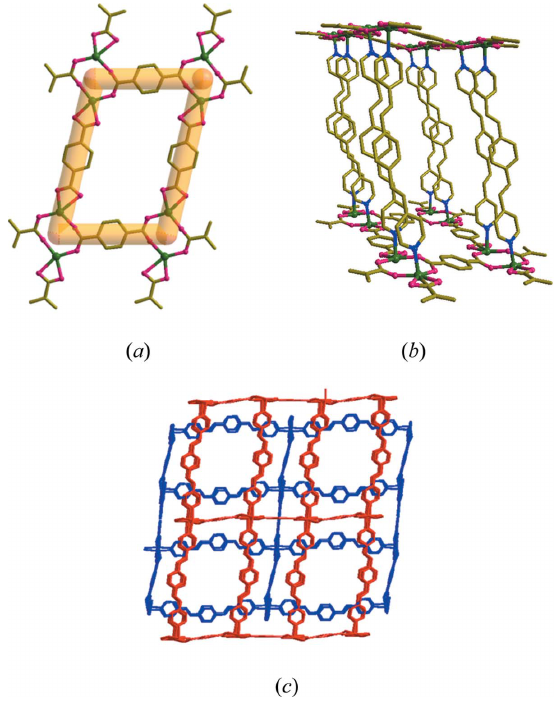
Figure 3 ( a ) The (4,4) net formed by Zn 2 (bdc) 2 in ( 3 ). ( b ) Single pcu unit showing the orientations of the bpeb pillars. ( c ) Twofold perpendicular interpenetration of the pcu units. For clarity, the hydrogen atoms are not shown.